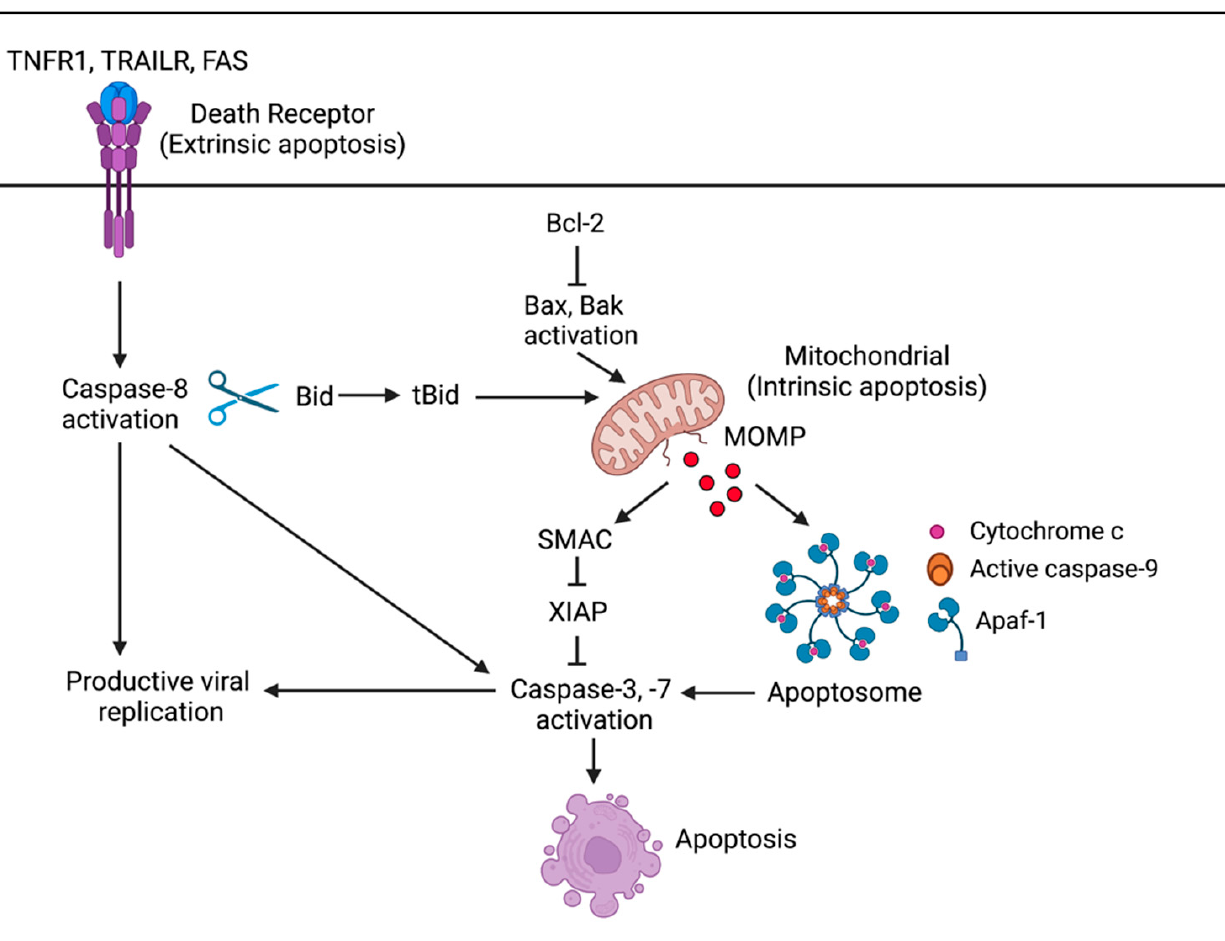
Figure 4. Overview of the extrinsic and intrinsic apoptotic pathways. The mitochondrial (intrinsic) pathway of apoptosis is activated by various cellular stresses (e.g., DNA damage, ER stress, ROS production, viral infection), resulting in mitochondrial outer membrane permeabilization (MOMP)